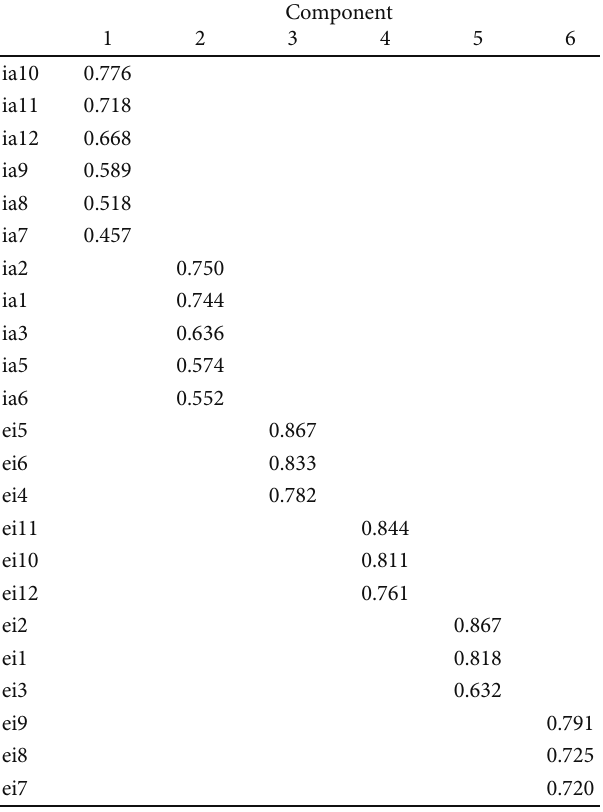
Table 7: Rotated component